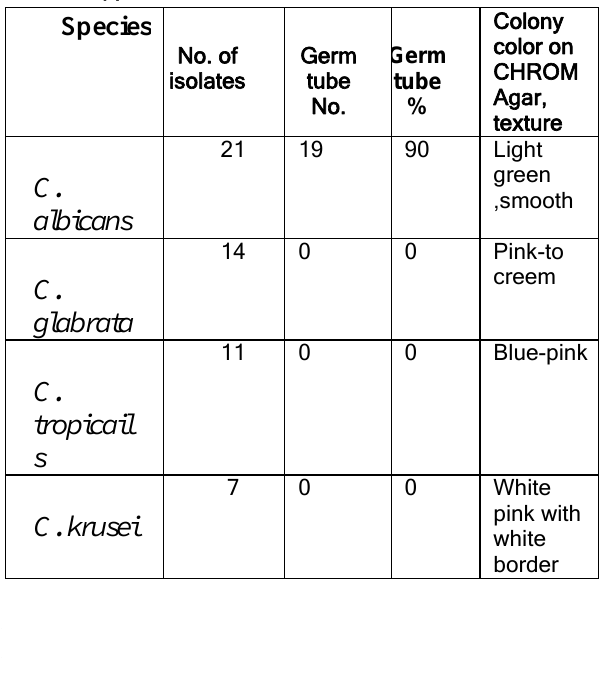
Figure(6): C. albicans germ tube formation ( red arrows) Out of 100 vaginal samples, only 53samples revealed positive vaginal candidiasis. Most of C. albicans isolates formed germ tubes . Almost all of the isolates after 24 -72 hrs of incubation on HiCrome Candida .Differential medium revealed a luxuriant light green colonies (C. albicans colonies). C. albicans species is the predominant as was showed in Table (1) and figure (5) and these results agree with the previous studies that almost all colonies form this color which was the light green on chromogenic media [17,18, 19]. In addition to that results showed that 90% of C. albicans isolates formed germ tubes which means that they are pathogenic isolates. These results are in line with those of Beheshti et al. (1975). Table 2. Germ tube formation and colony color of vaginal Candida spp.